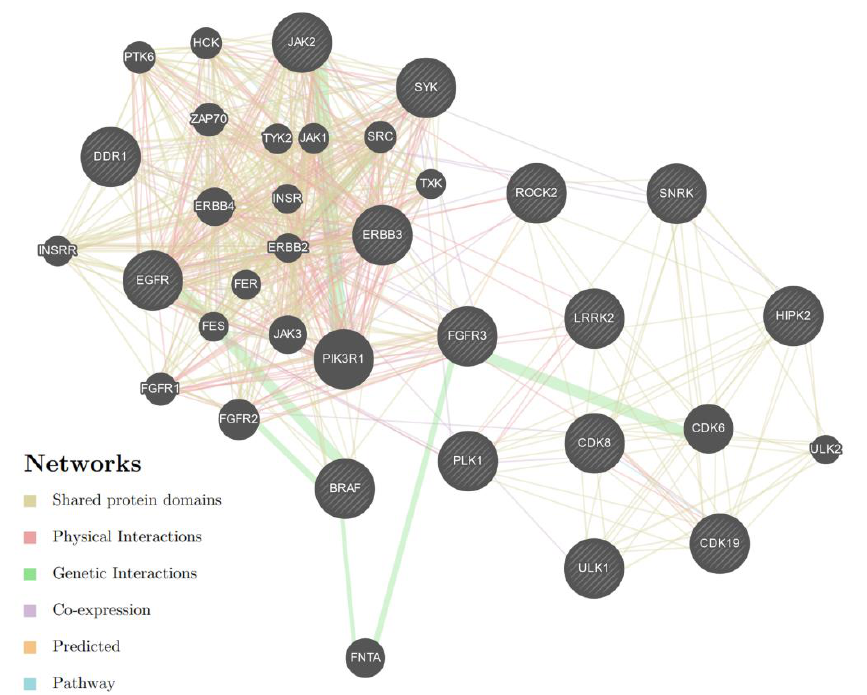
Figure 2. Interaction network of micro-RNA associated kinases as obtained from “Genemania” [40,41]. A total of 15 kinases associated with the tamoxifen-regulated micro RNAs (Table 4) were used for this analysis (shaded circles) and a further 20 genes were added by the Genemania algorithm.